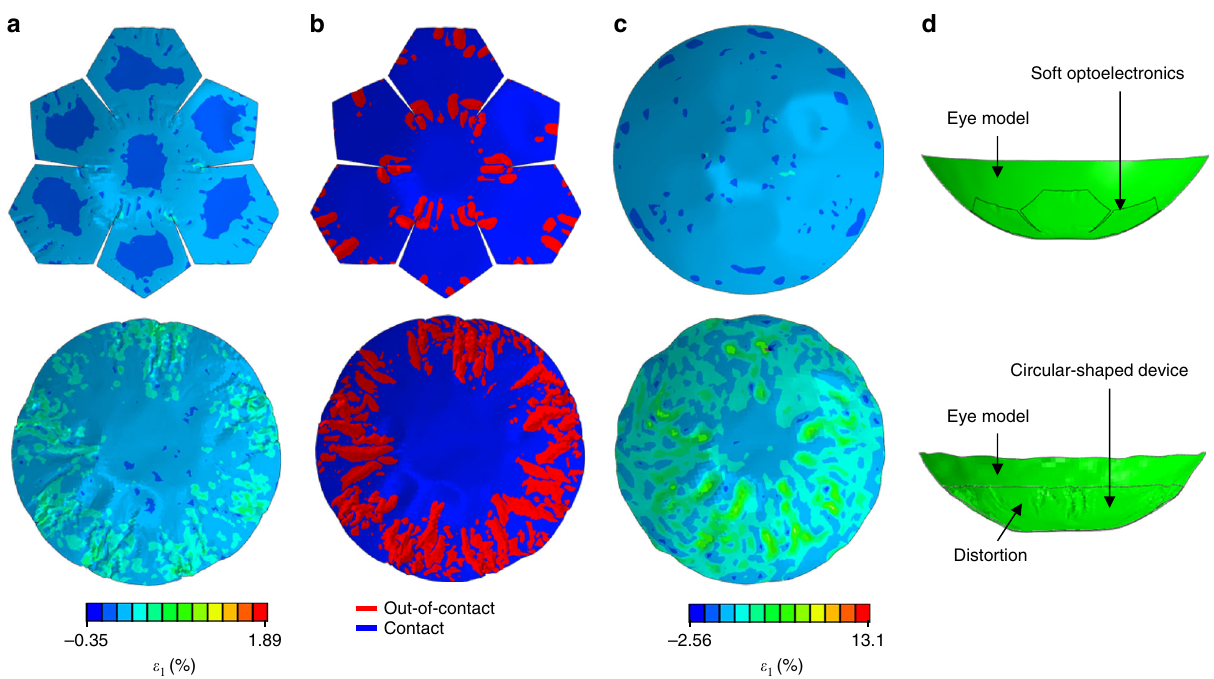
Fig. 5 Finite element analysis of the soft optoelectronic device and the eye model. a Maximum in-plane principle strain distribution in the soft optoelectronic device (top) and the circular device (bottom). b The reddish out-of-contact part of the soft optoelectronic device (top) and the circular device (bottom). c Maximum in-plane principle strain distribution in the eye models attached by the soft optoelectronic device (top) and the circular device (bottom). d Deformed shape of the eye model attached by the soft optoelectronic device (top) and the circular device (bottom) obtained by the